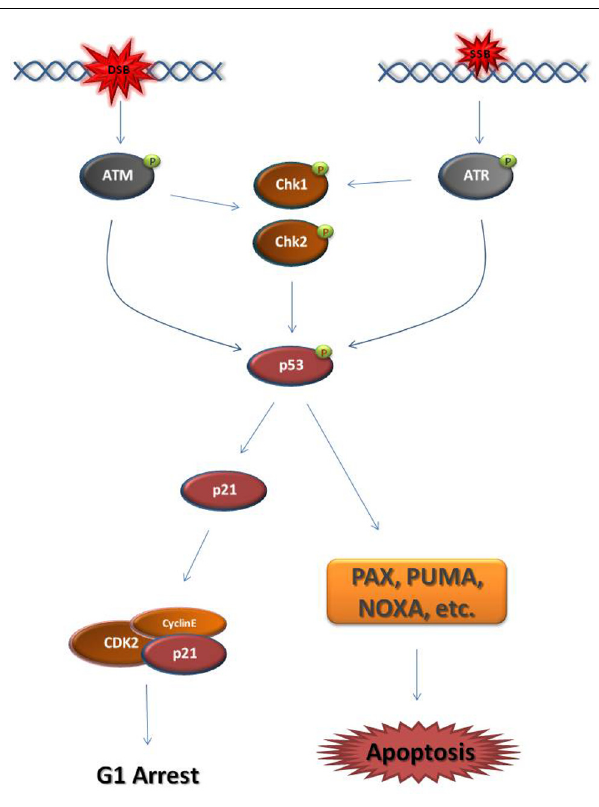
FIGURE 2 | Schematic representation of the major steps of the G2 DNA damage checkpoint. At S/G2 phase, DSBs and SSBs activate ATM and ATR, respectively. As a consequence, checkpoint kinases Chk1 and Chk2 become activated. Chk1 and Chk2 can directly phosphorylate